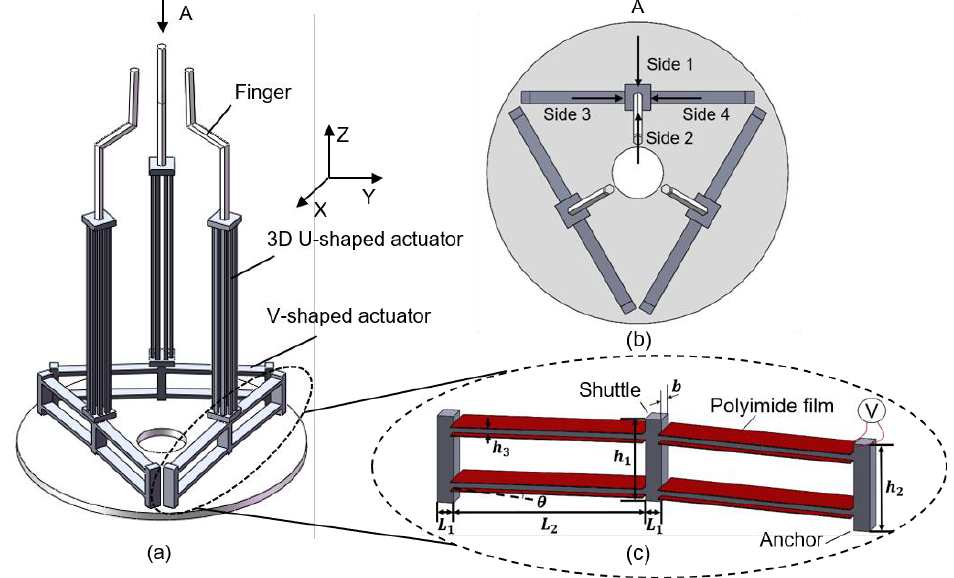
Figure 1. The structure of the 3D electrothermal microgripper. ( a ) Structure of the 3D electrothermal microgripper; ( b ) Top view of the 3D microgripper; ( c ) The V-shaped electrothermal actuator.